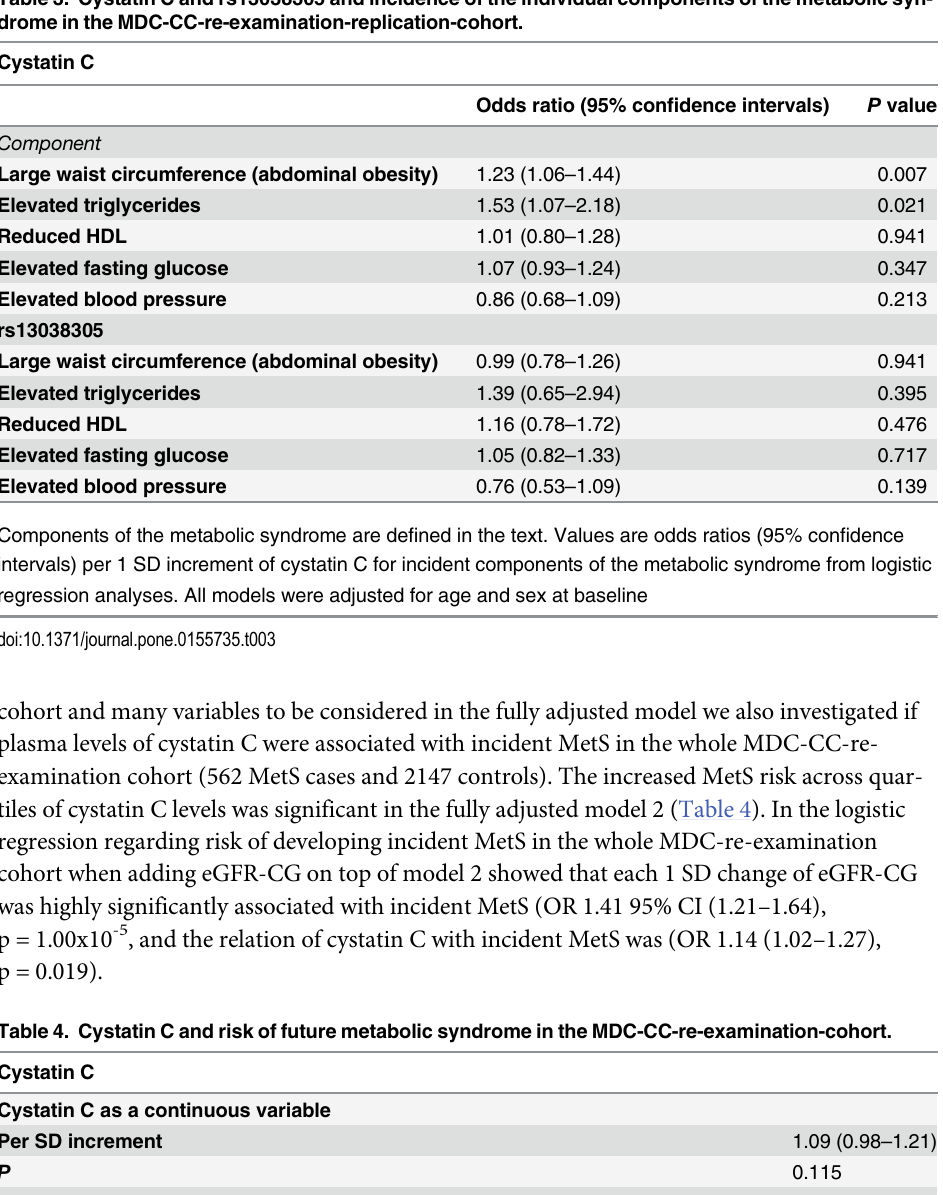
Table 4. Cystatin C and risk of future metabolic syndrome in the MDC-CC-re-examination-cohort. Cystatin C